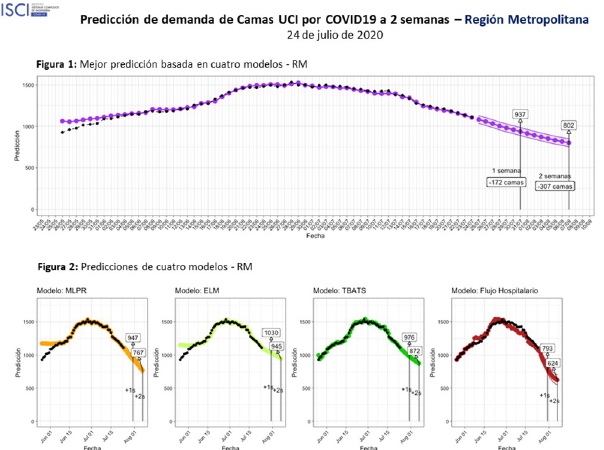
Fig 3. Government report: 24 July—Metropolitan